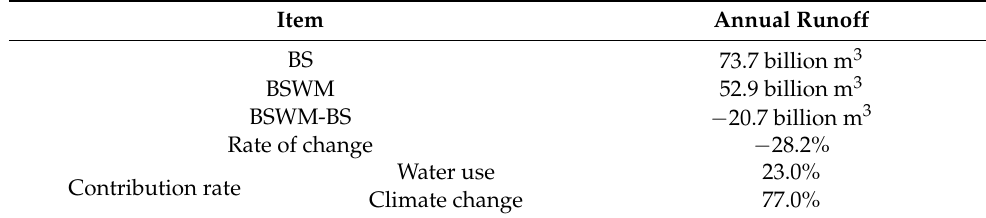
Table 4. Contributions of various factors to annual runoff reduction in the SRB.